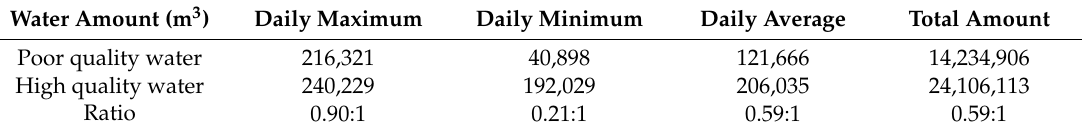
Table 4. Amounts of poor- and high-quality water during a drought event in 2011.